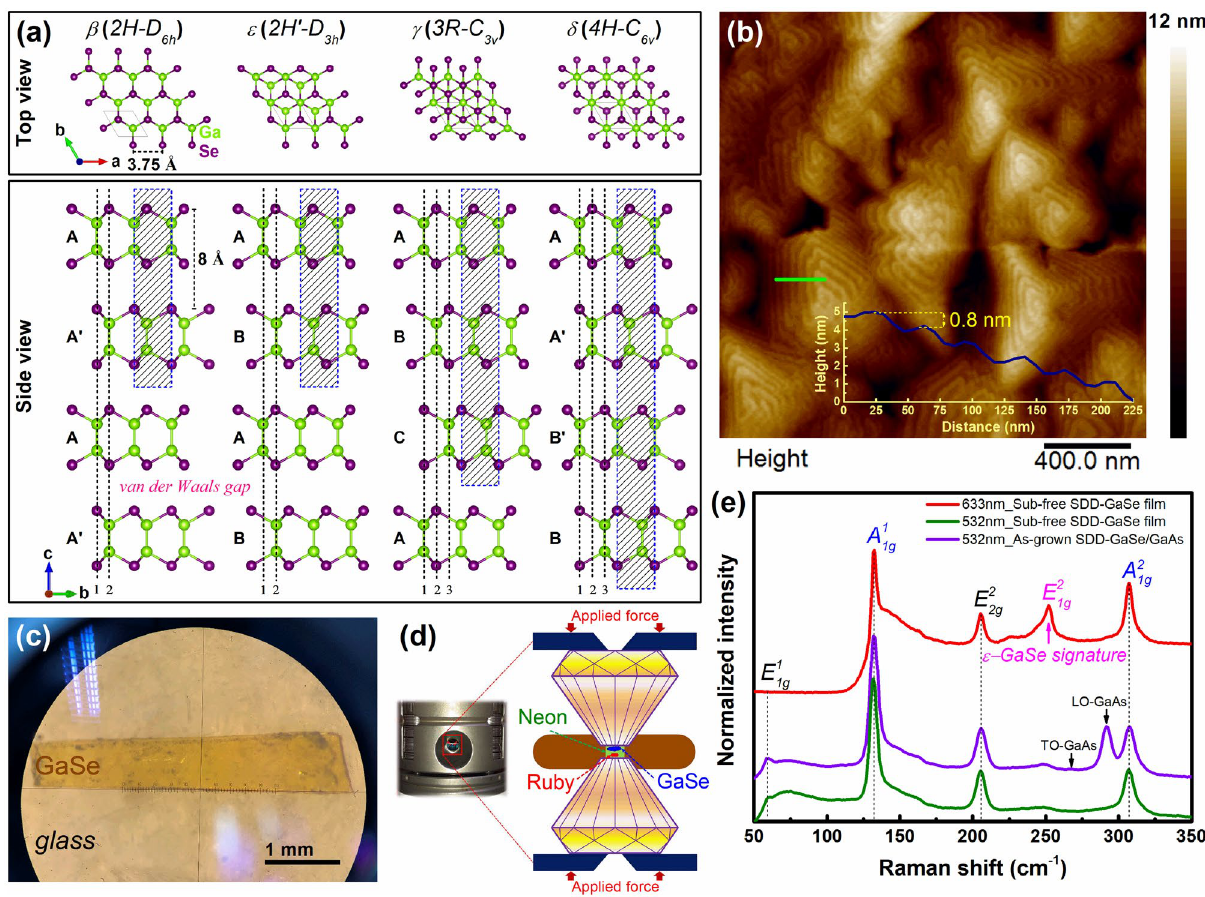
Figure 1. (a) Polytypic crystals of 2D GaSe materials visualized by VESTA program 32 . (b) AFM image of ε -SDD-GaSe grown on GaAs (001) substrate by MBE; inset of (b) is step-height profile corresponded to the green line. (c) Optical image of a free-standing SDD-GaSe film on glass after substrate removal. (d)